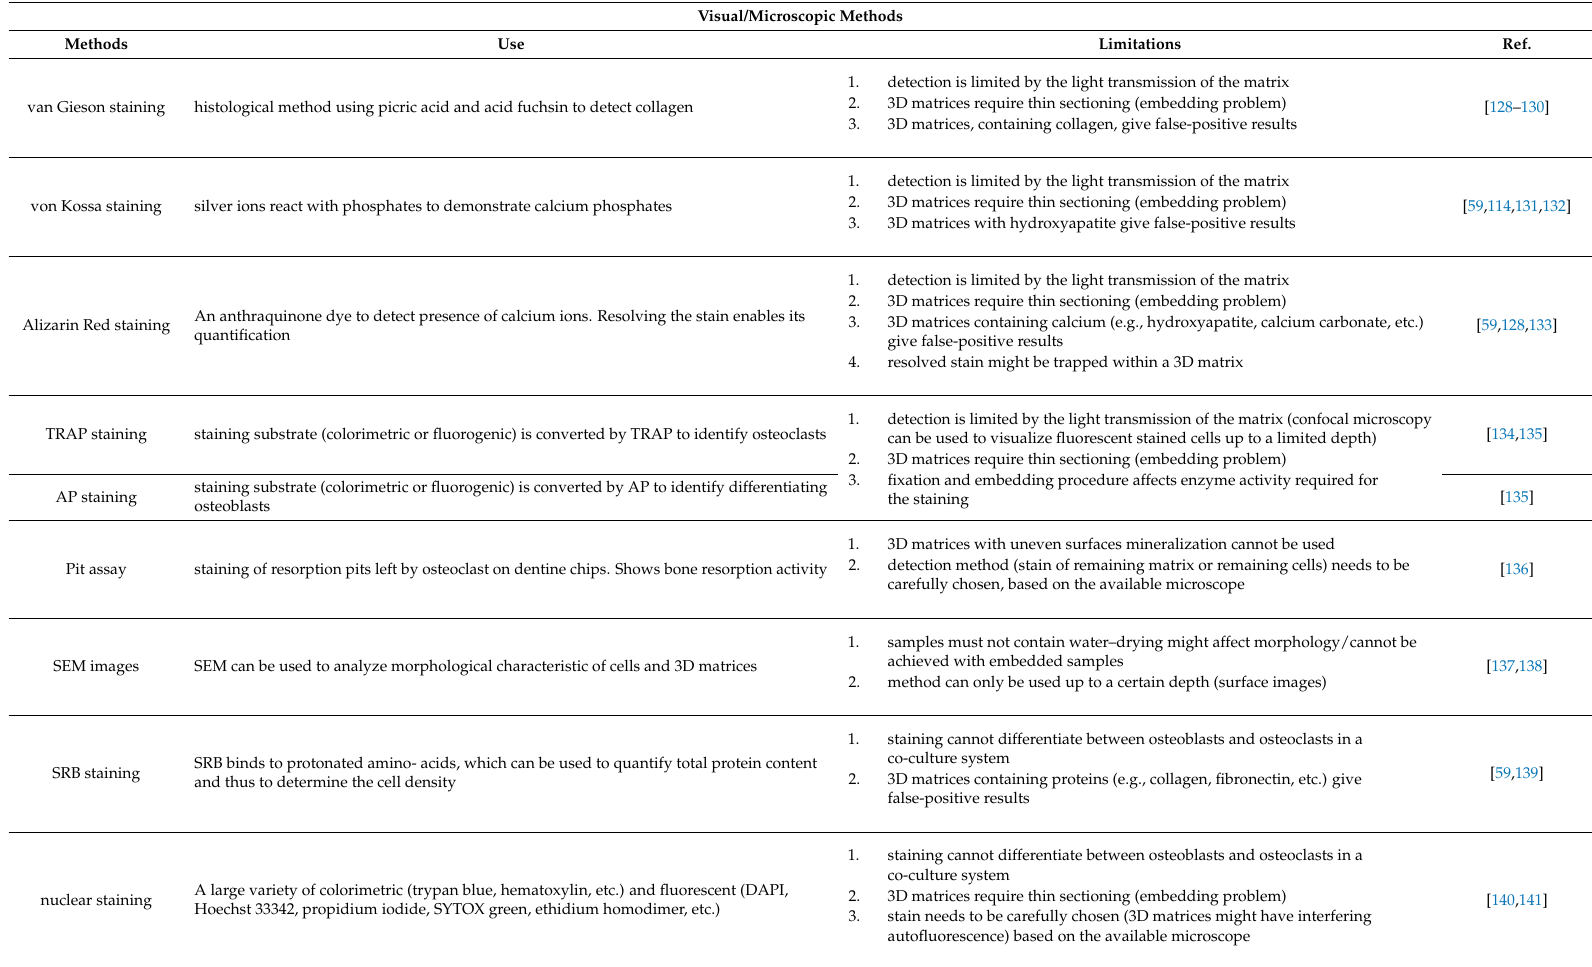
Table 4. Methods to characterize and normalize osteoblast and osteoclast